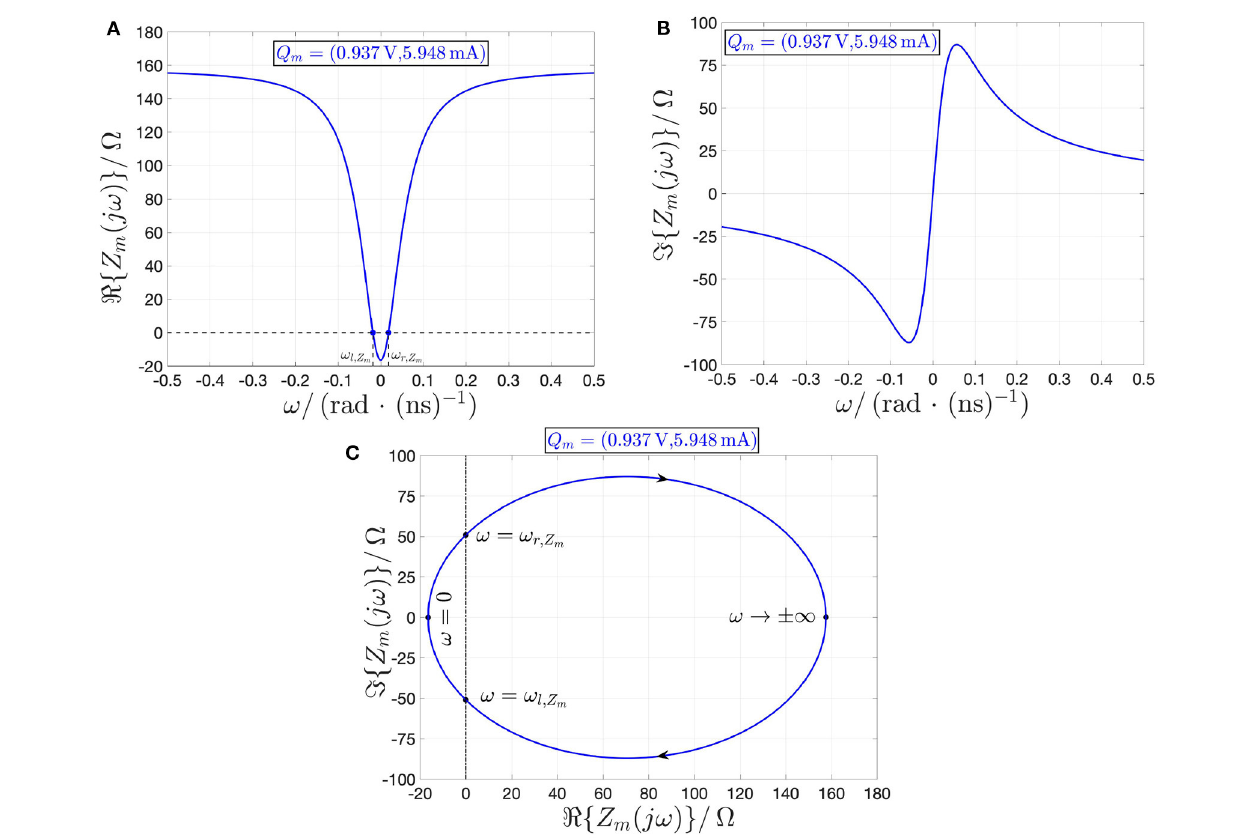
Z m ( j ω ) Z m ( j ω ) vs. locus, extracted from ℑ{ } ℜ{ } to . The real part of the local −∞ +∞